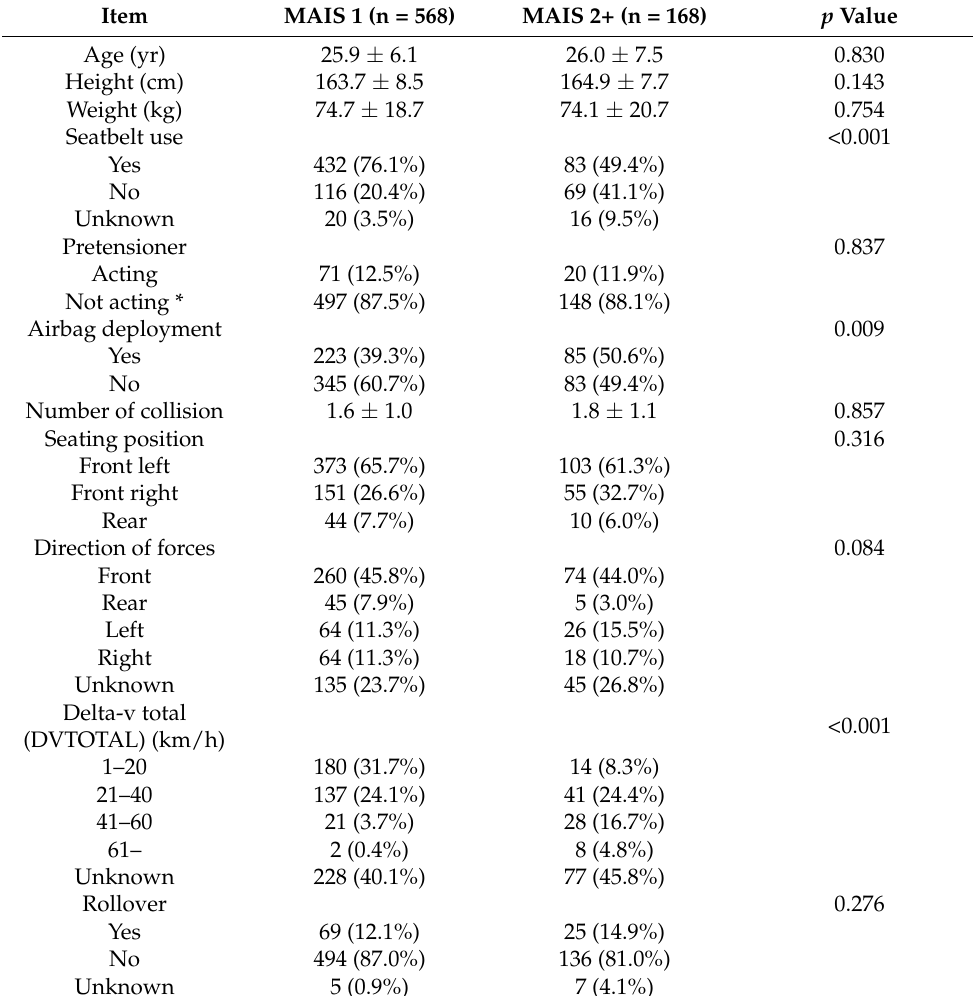
Table 1. Comparison of the background and collision characteristics of pregnant women with a MAIS of one (n = 568) or two or more (n = 168).